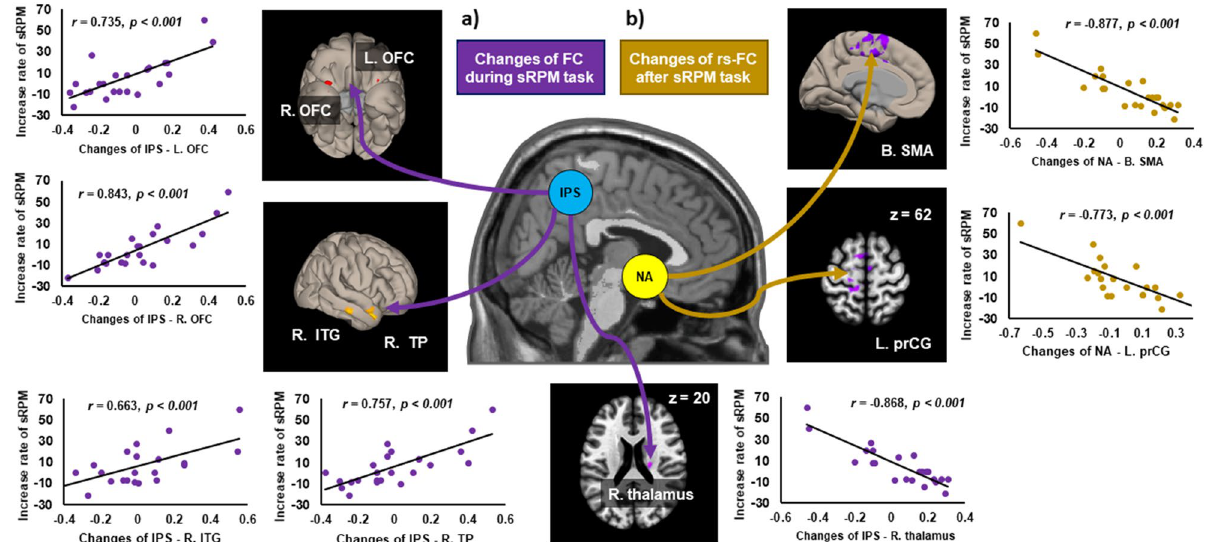
Figure 2. Scatter plots showing the relationships between during-task ( a ) and post-task ( b ) changes in inter- regional functional connectivity (FC) and score increase rates of the short form of Raven’s Progressive Matrices (sRPM) in the self-respect group. rs-FC, resting-state functional connectivity; L. left, R. right, B. bilateral, NA nucleus accumbens, IPS intraparietal sulcus, SMA supplementary motor area, PrCG precentral gyrus, OFC orbitofrontal cortex, ITG inferior temporal gyrus, TP temporal